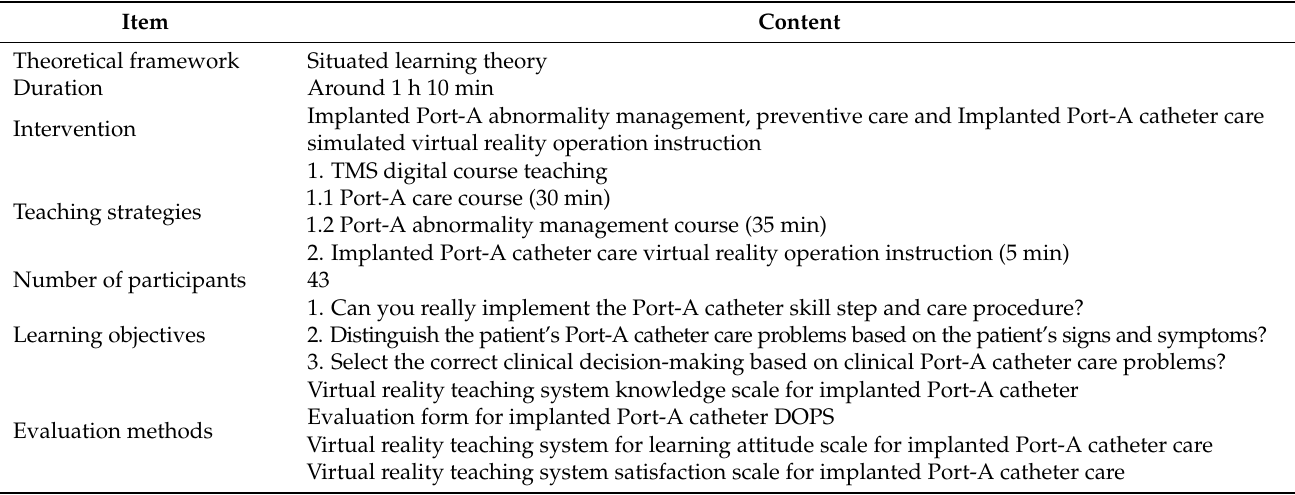
Table 2. Teaching